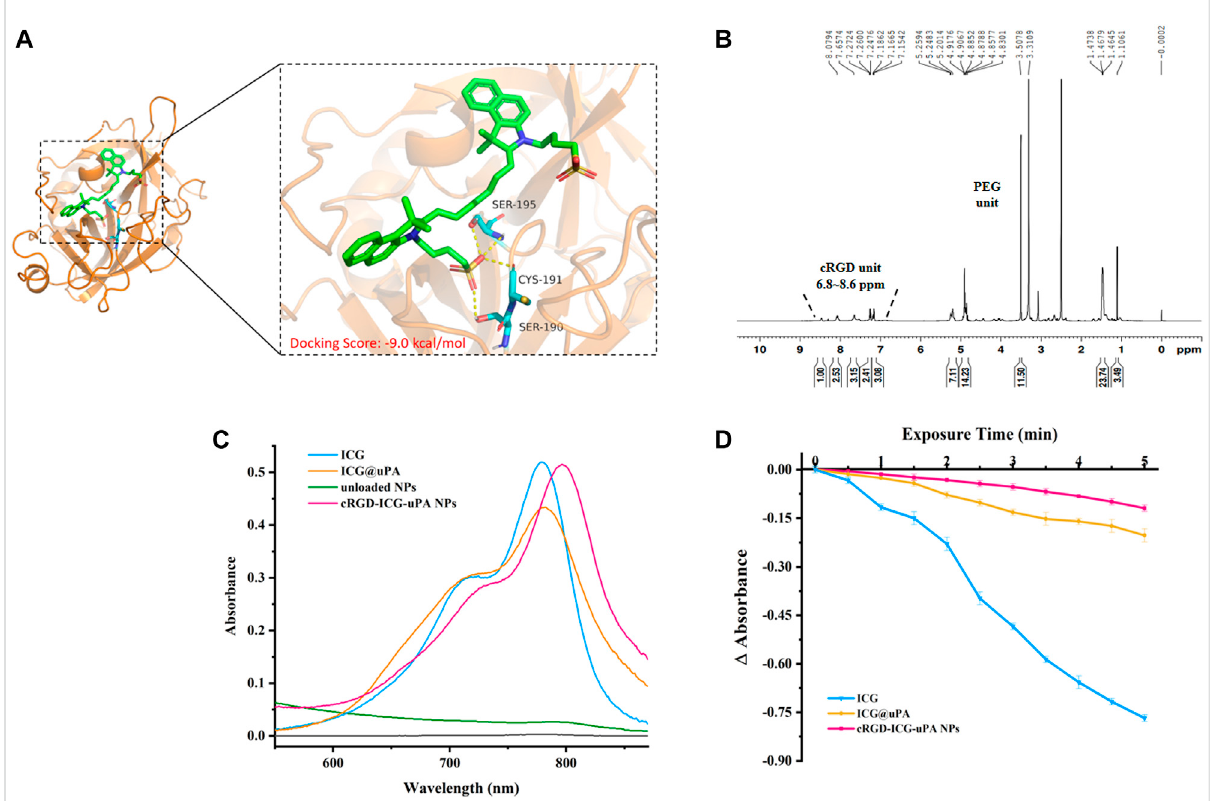
FIGURE 1 (A) ThepredictedbindingmodebetweenICGanduPA.ThekeyresiduesofICGinteractingwithuPAareshownintheenlargedview. (B) H 1 NMR spectrumofcRGD-PEG-PLGA(600 MHz,DMSO- d6 ,300 K). (C) AbsorbancespectraoffreeICG,ICG@uPA,unloadedNPs,andcRGD-ICG-uPANPs in aqueous solutions. (D) Absorbance reduction curves of free ICG, ICG@uPA and cRGD-ICG-uPA NPs in aqueous solution under irradiation with 808 nm laser (1 W/cm 2